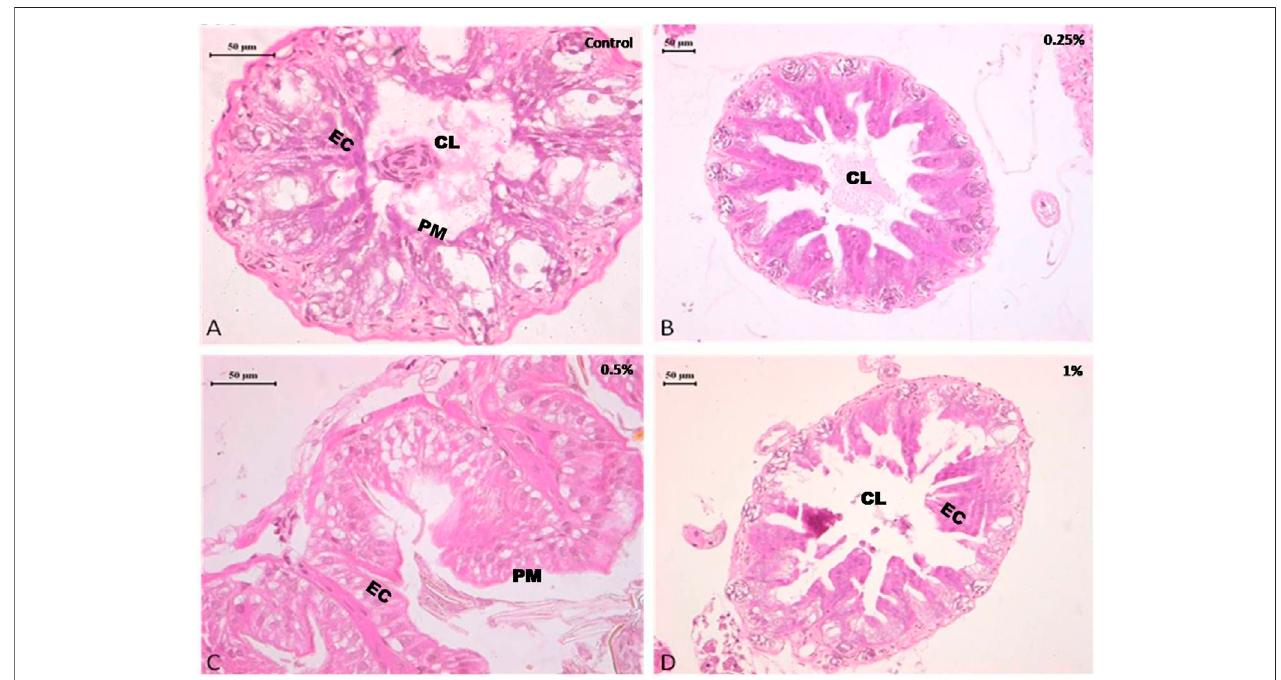
FIGURE 4 | Photomicrograph of control and deltamethrin treated cockroach ( P. americana ) mid gut: (A) Control; (B) treated with 0.25% deltamethrin; (C) treated with 0.5% deltamethrin; (D) treated with 1% deltamethrin. EL, epithelial cells; CL, central lumen; PM, peritrophic membrane.